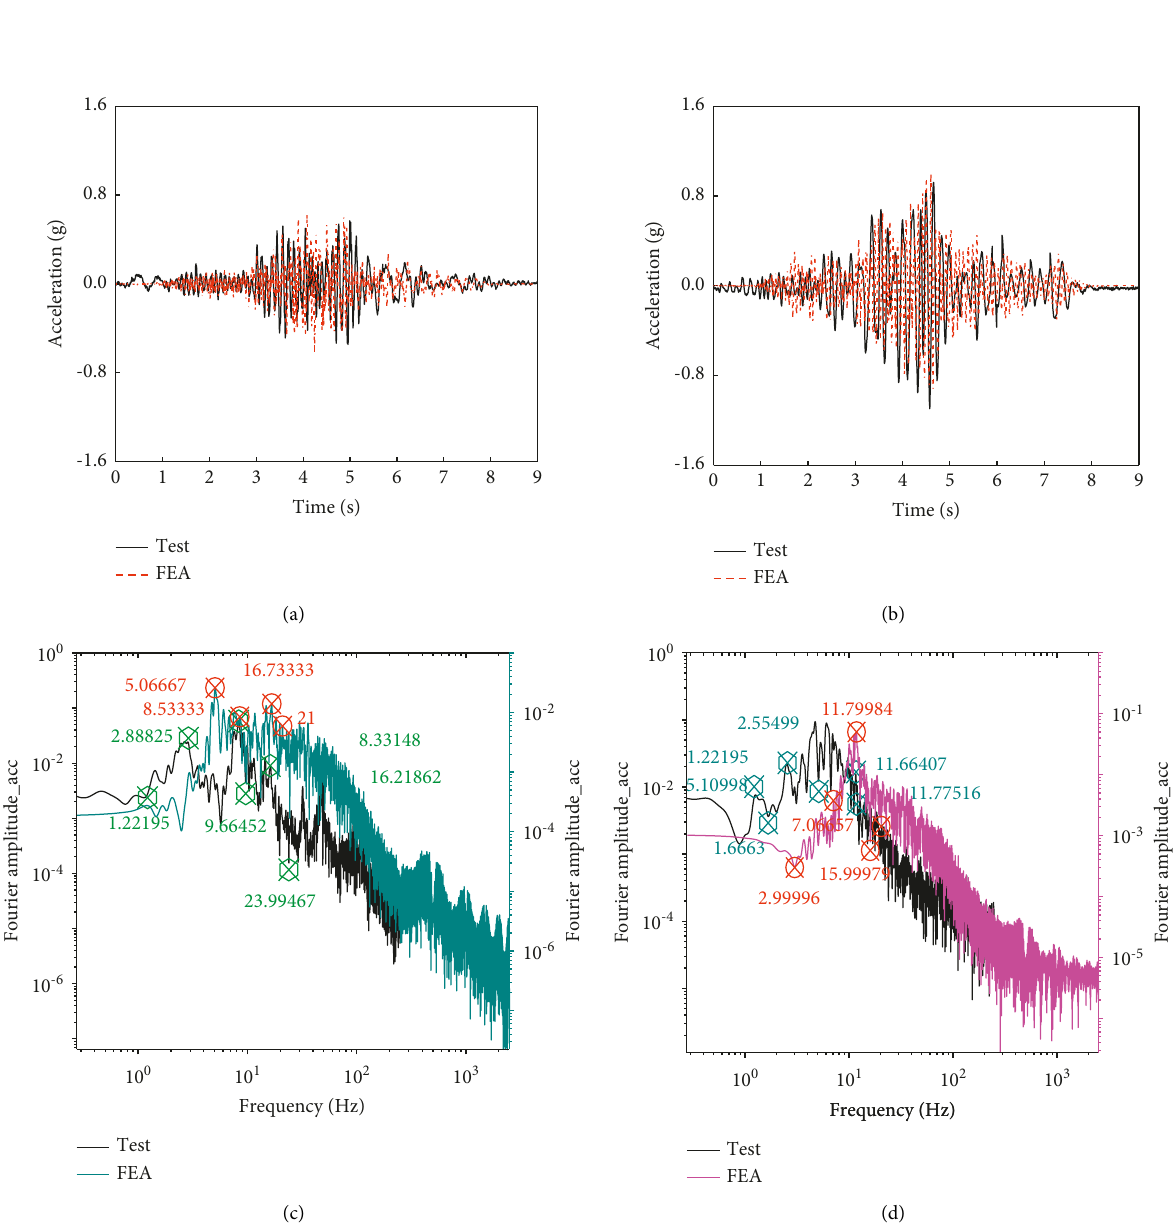
Figure 10: Acceleration time histories comparison under 0.45g excitation: (a) in x direction; (b) in y direction. Fourier spectrum cor- responding to (a). (d) Fourier spectrum corresponding to